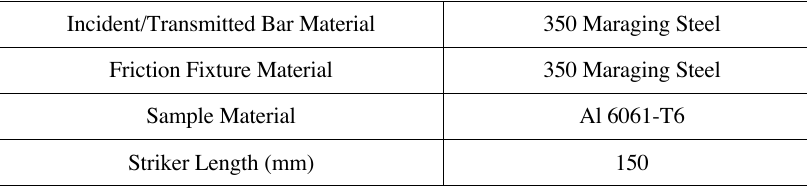
Fig. 2. Illustration of FLAG simulation setup highlighting key boundaries and interfaces. Table 1. Simulation